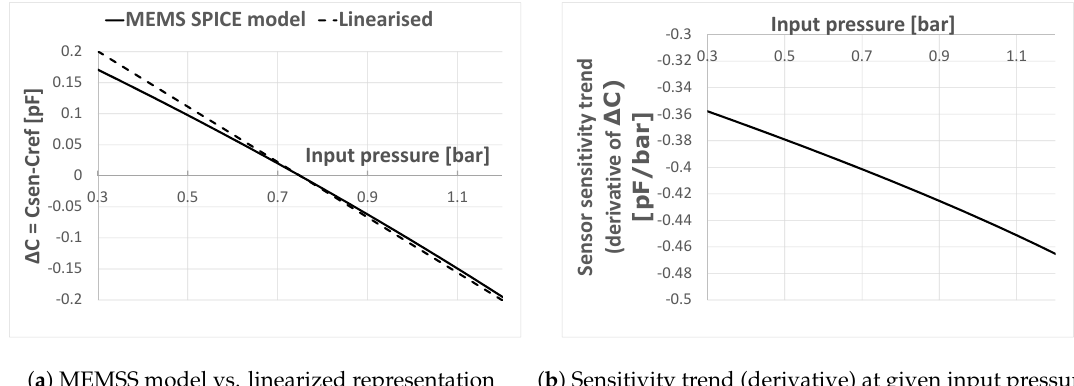
Figure 6. ∆ C reading of sensor model ( a ); and sensitivity (derivative) ( b